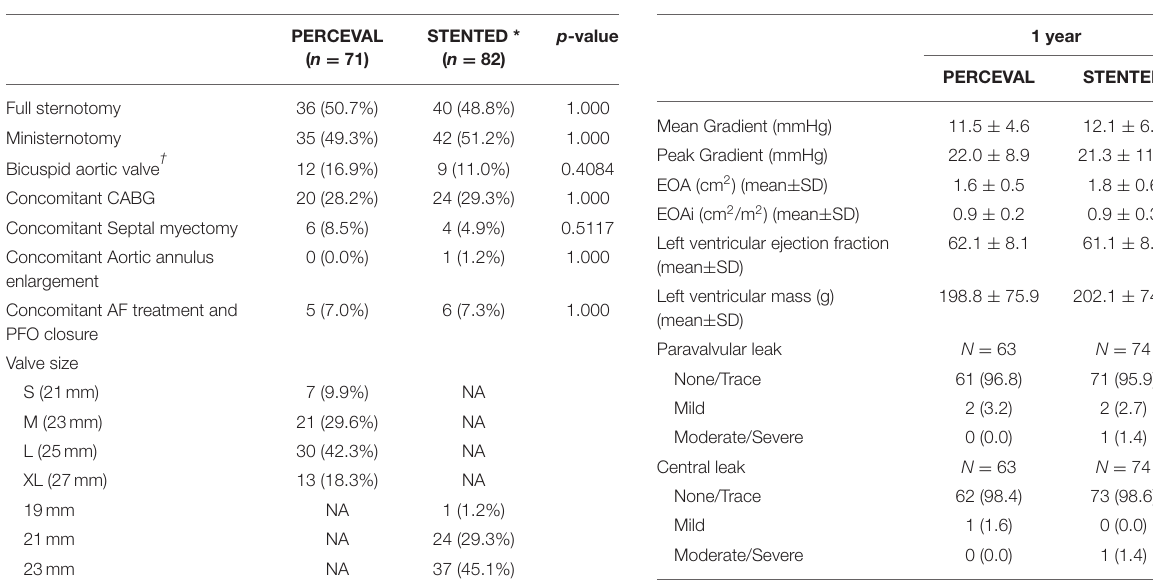
TABLE 3 | Intraoperative characteristics. TABLE 4 | Hemodynamic data up to 1-year visit